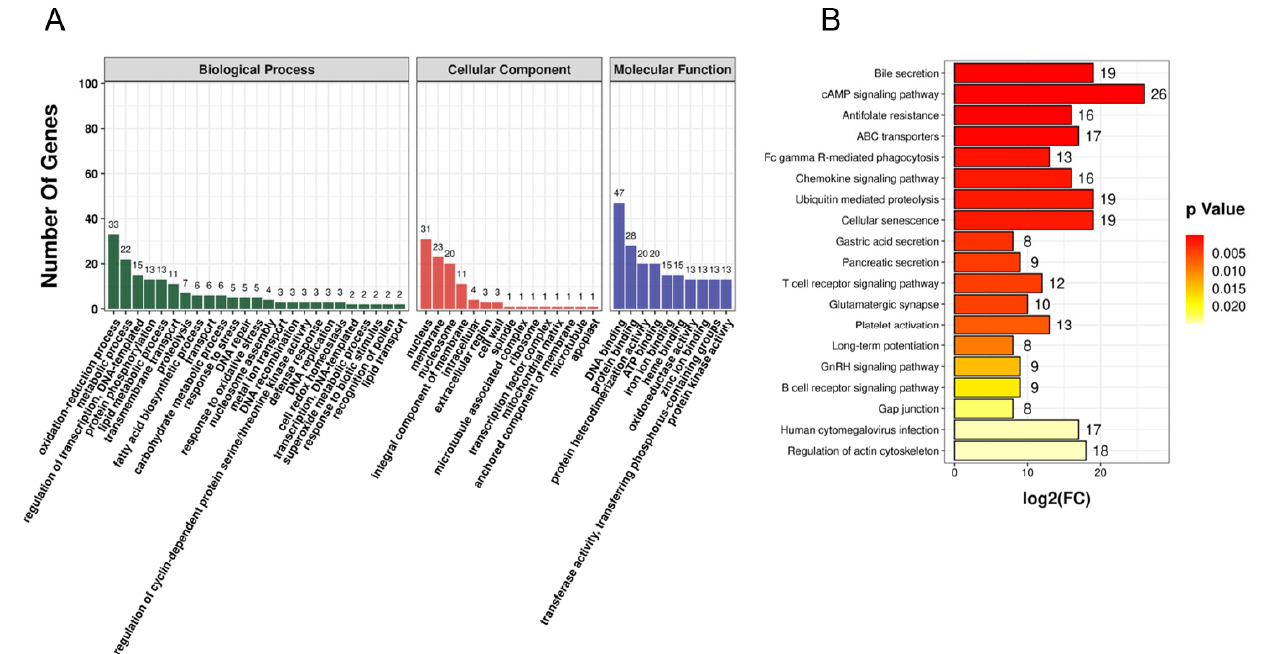
Figure 4. The GO and KEGG analysis of host genes of DECs between P-Buffalo and C-Buffalo. ( A ) An examination of the top enriched terms of the DEC host genes found in P-Buffalo and C-Buffalo was performed by GO analysis. the DEC host genes were divided into three classes (blue bars: biological processes, green bars: cellular components, orange bars: molecular functions). ( B ) Enrichment profiling of the top KEGG pathway for host genes of DECs discovered in P-Buffalo and C-Buffalo.